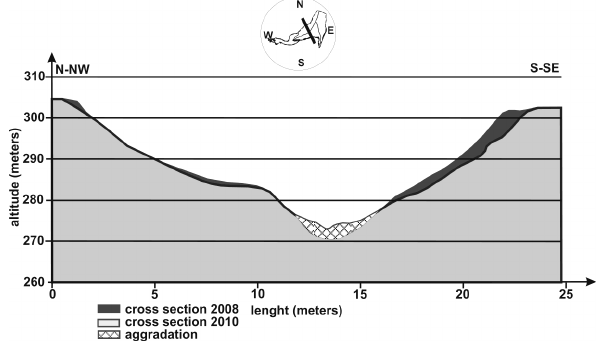
Fig. 15. Cross-section of the main gullies in the downstream.